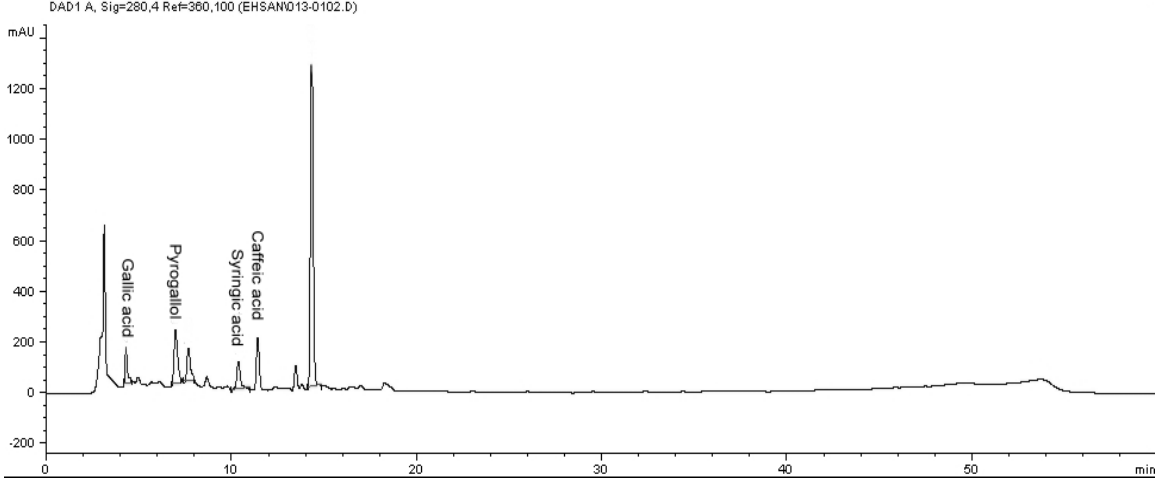
Figure 2. The RP - HPLC chromatogram of phenolic compounds in methanolic extract of Citrus aurantium bloom . Identified compounds: Gallic acid, pyrogallol, syringic acid and caffeic acid.